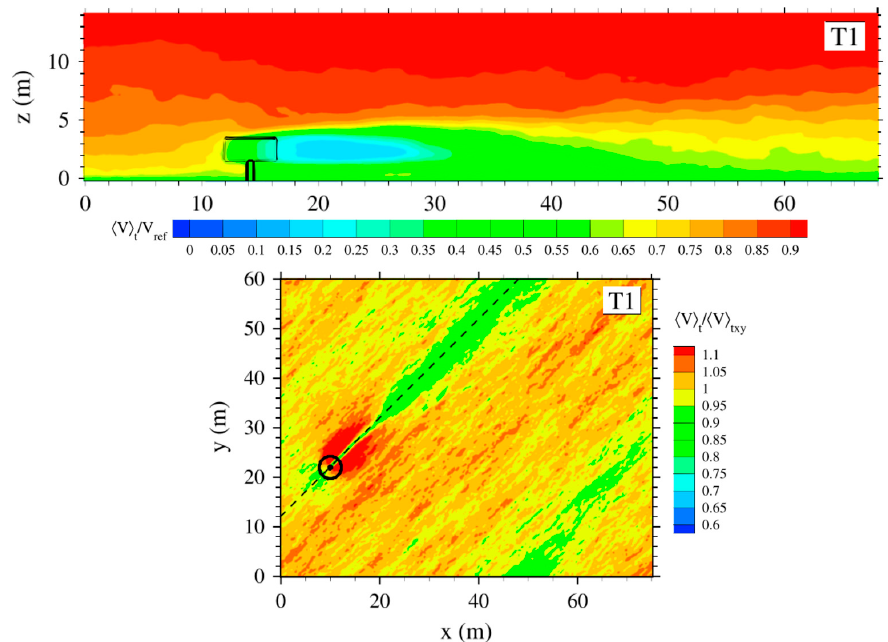
Figure 2. Flow visualisation downwind of a single tree, shown as: (top panel) the normalised time-averaged wind velocity (V t /V ref ) simulated by Dupont et al.’s [52] model, shown in vertical cross-section. Solid black lines delimit the tree; (bottom panel) the normalised time-averaged wind velocity (V t /V txy ) simulated by the model at 0.1 m height, shown in horizontal cross-section. The solid black circle represent the tree crowns (adapted from [52] (p. 176)).